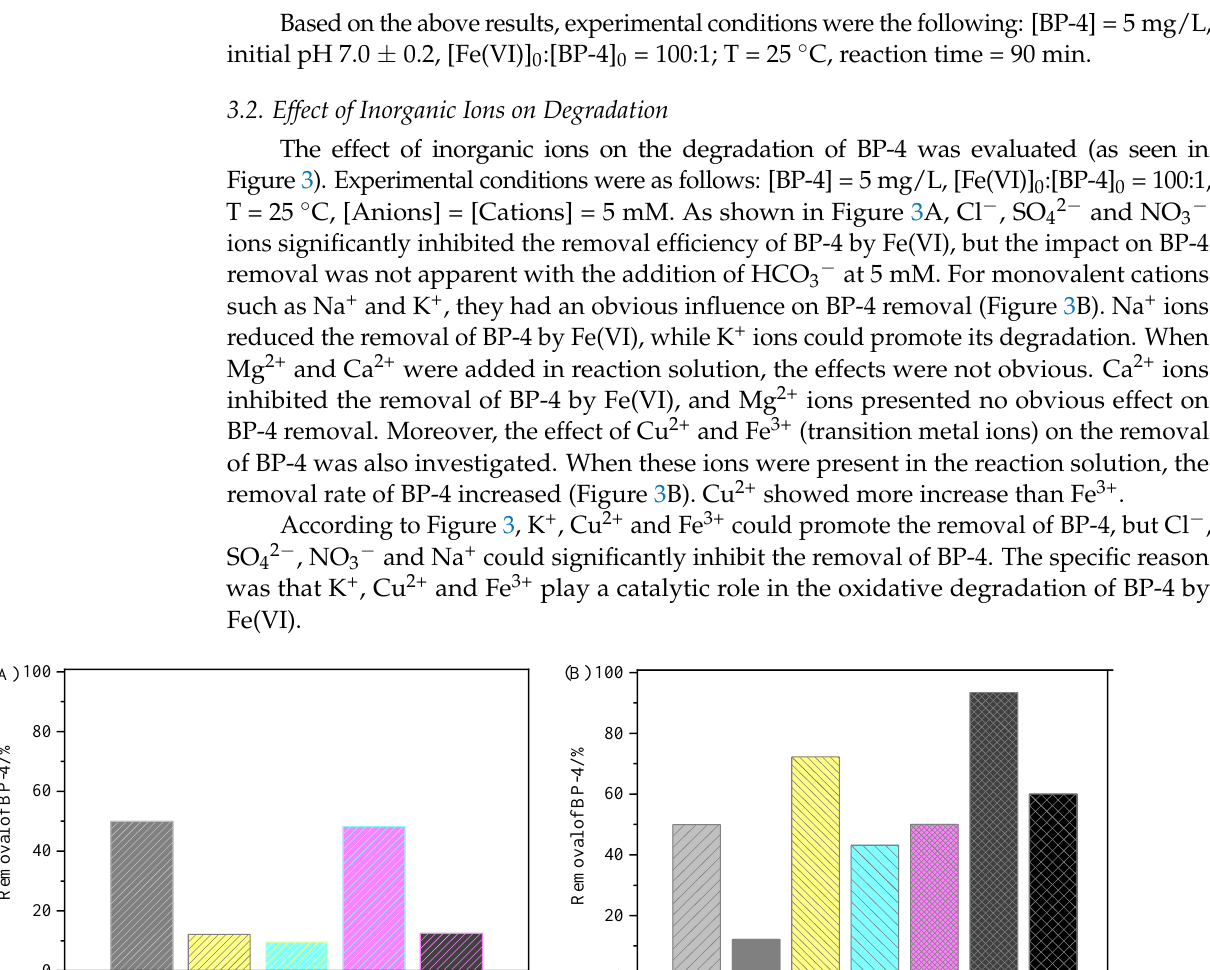
Figure 2. Effect of initial solution pH ( A ) and temperature ( B ) on BP-4 removal by Fe(VI) (experimental conditions: [BP-4] 0 = 5 mg/L; T = 25.0 °C for pH (initial pH 7.0 ± 0.2 for temperature); [Fe(VI)] 0 :[BP-4] 0 = 100:1; reaction time = 90 min).